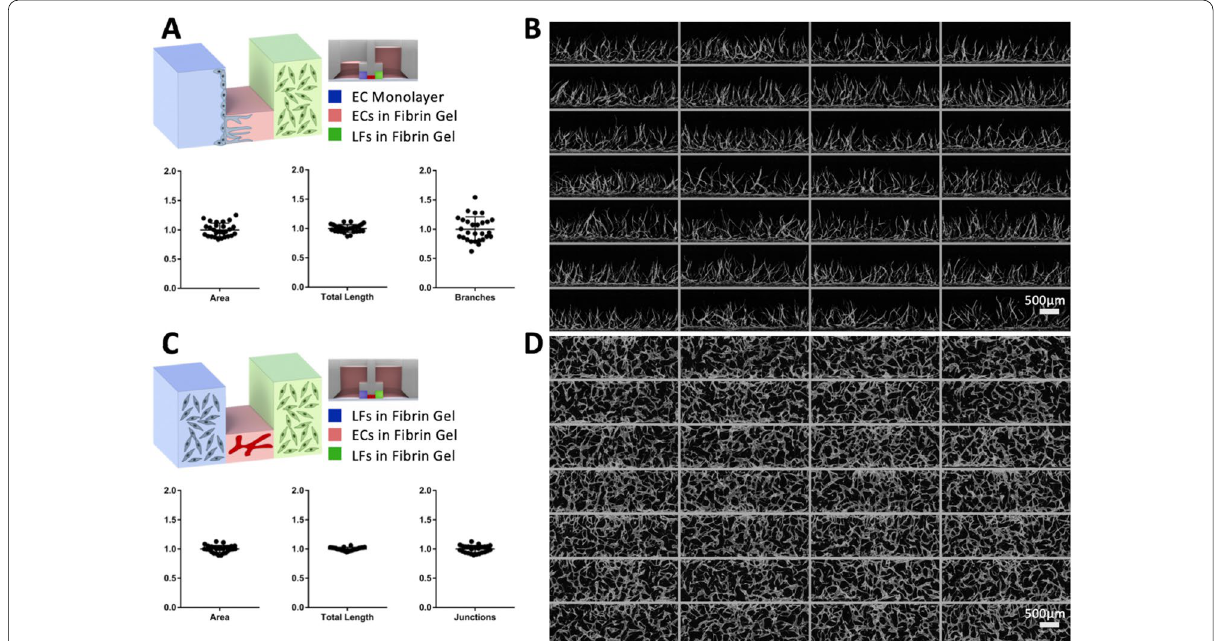
Fig. 3 Overview angiogenesis and vasculogenesis patterning configurations and sample output. A Schematic diagram of an angiogenesis assay. 1 µL of acellular fibrin gel is patterned in the central lane (red), followed by 2.5 µL of lung fibroblasts in fibrin gel (green) in the right side lane, and 2.5 µL of HUVEC suspension deposited as a confluent monolayer is seeded in the left (blue) side lane. Flow from the LF to EC compartments is induced by adding media to the LF side reservoir. Adjusted standard deviations for Area, Total Length, and Branches are: 0.1118, 0.0626, and 0.2047, respectively (n 28). B Sample 28 well imaging output of angiogenesis within a single injection molded chip, center lane (red) was selected as ROI. = C Schematic diagram of a vasculogenesis assay. 1 µL of HUVECs suspended in fibrin gel is patterned in the central lane (red), followed by 2.5 µL of LFs in fibrin gel in both the right (green) and left (blue) side lanes. Adjusted standard deviations for Area, Total Length, and Junctions are: 0.0596, 0.0276, and 0.0594, respectively (n 28). D Sample 28 well imaging output of vasculogenesis within a single injection molded chip, center lane = (red) was selected as ROI. The measurement was performed after 7 days of